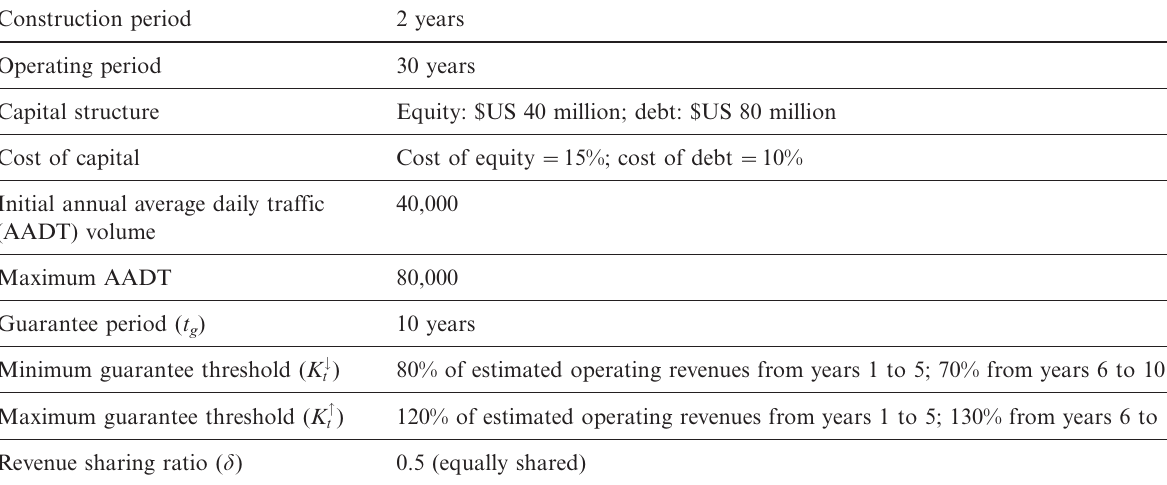
Table 2. Characteristics of a BOT highway example project